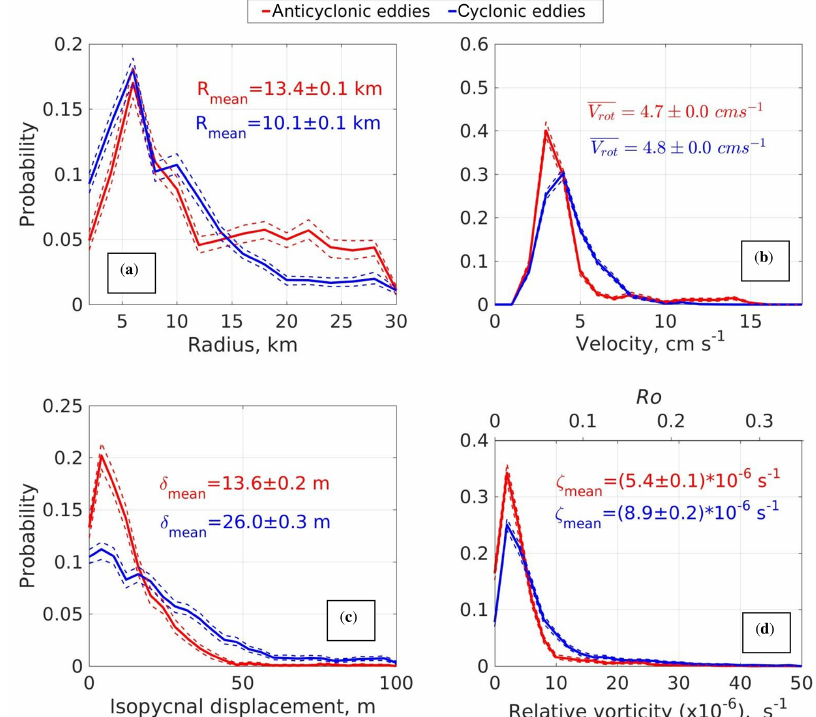
Figure 6. Probability distribution function of eddy radii (a) , rotational current speed (b) , amplitude of isopycnal displacement (c) , and relative vorticity (d) estimated using MMP observations at mooring M1f. Dotted lines on the panels indicate the 95% confidence interval estimated by the bootstrap method. Red is used for anticyclonic eddies; blue is used for cyclonic